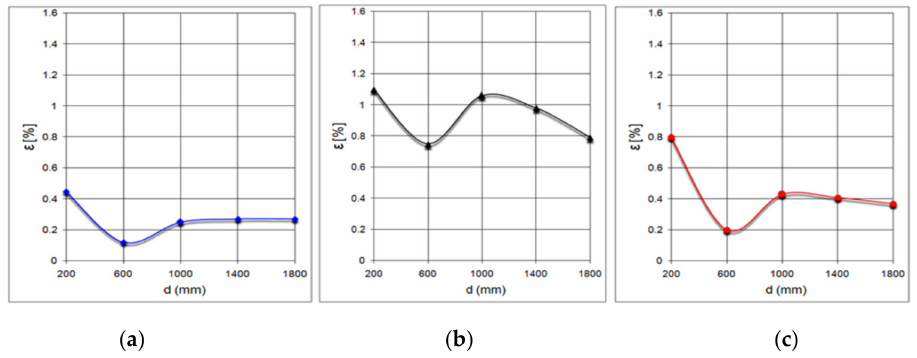
Figure 19. Measuring the distance to obstacles of different shapes. ( a ): variation error for rectangular objects, ( b ): variation error for triangular prism, ( c ): variation error for cylindrical object. Measurements with the XL Maxbotix EZ0 ultrasonic sensor were performed at atmo- spheric pressure of 711.4 mmHg and temperature of 20.6 ◦ C (293.75 K). In this case, the speed of sound propagation has the value c air = 344